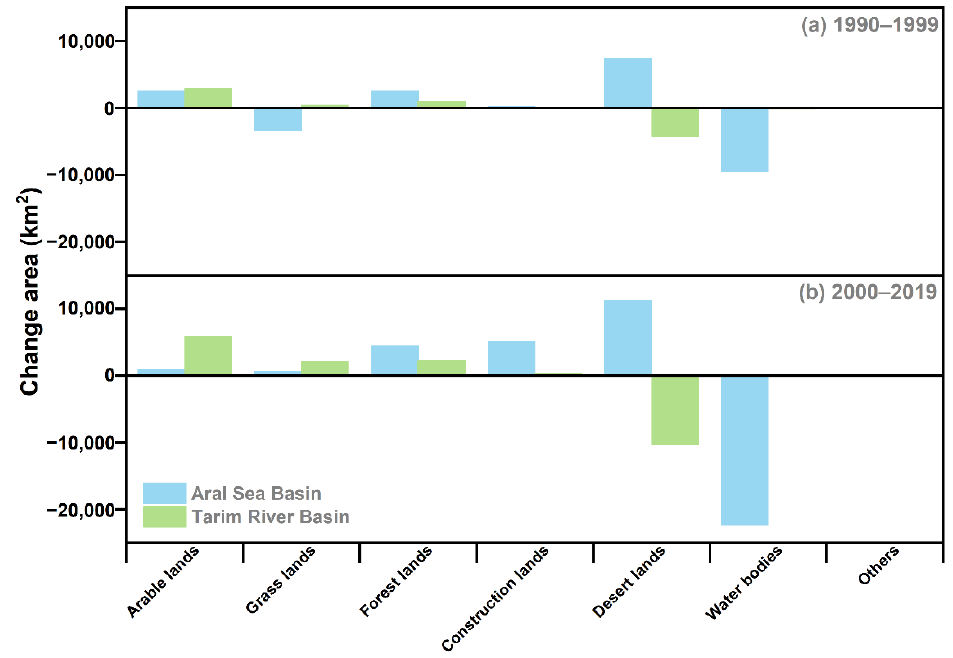
Figure 4. Changes in areas of different land use types before and after EWC in the Aral Sea Basin and the Tarim River Basin, Central Asia.